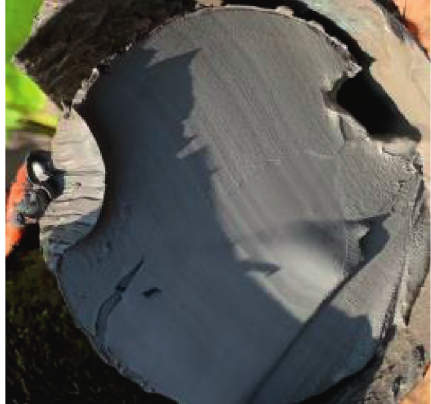
Figure 2: Typical photos of the field contaminated soils (layer (4)). Table 1: The properties of organic pollutants (20 ° C).